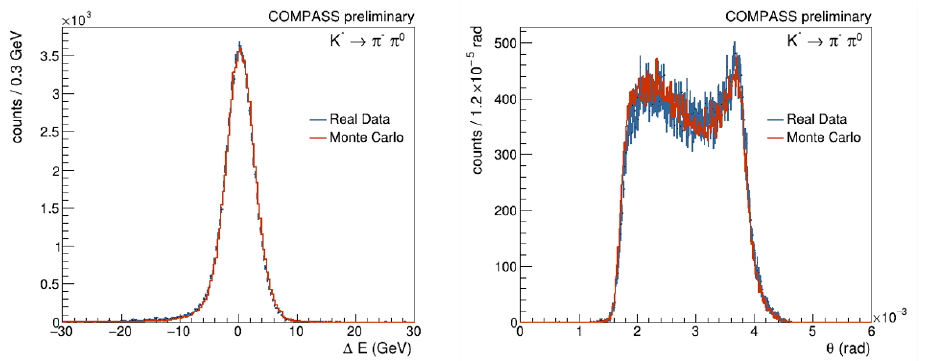
Figure 3. Comparison of the final-state laboratory energy of the Kaon decay products π − π 0 , minus the beam energy (left), and the angular distribution of the outgoing pions (right) with the Monte-Carlo description.